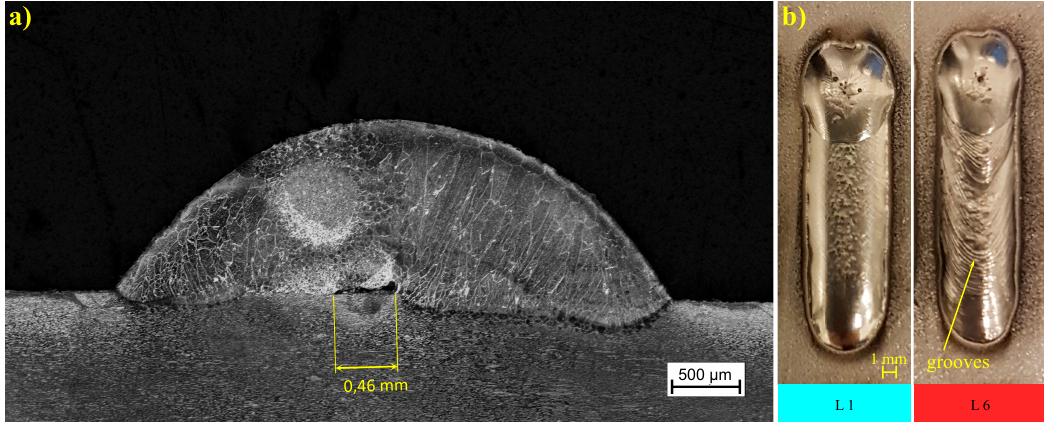
Figure 11. The examples of defects identified in the deposited beads: ( a ) the lack of fusion in the middle of the bead, ( b ) a comparison of surface conditions obtained by applying two different levels of the hot-wire–smooth surface, the hot-wire level L1 (image to the left), rough surface with groves, the hot-wire level L6 (image to the